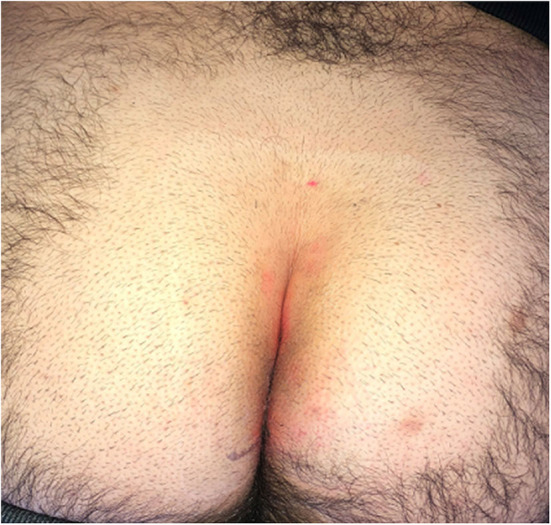
Laser epilation therapy included the natal cleft and an additional 5 cm area on both sides (left/right).